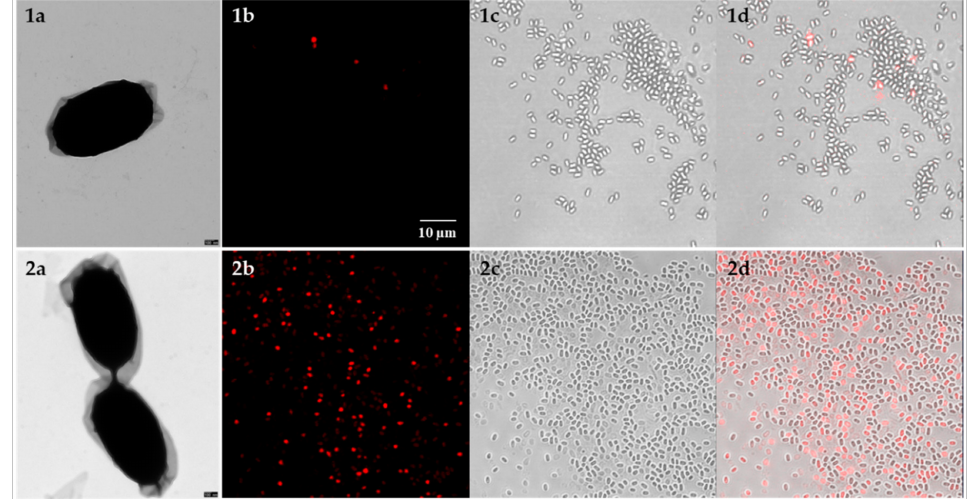
Figure 3. Disruption of B. anthracis spores after bead-beating observed by TEM and fluorescence microscopy. Micrographs show untreated spores ( 1 ) and spores after bead-beating ( 2 ); ( a ) TEM of negatively stained B. anthracis Sterne spores (Scale bar: 100 nm); confocal laser scanning microscopy images of B. anthracis spores pre-treated with PMA before ( 1b – d ) and after ( 2b – d ) mechanical disruption of spores by bead-beating; ( b ) red channel (PMA dyed) to detect spores with compromised spore coat, cortex and membranes; ( c ) bright field image, ( d ) Overlay of bright field and PMA signal (scale bar for all light micrographs: 10 µ